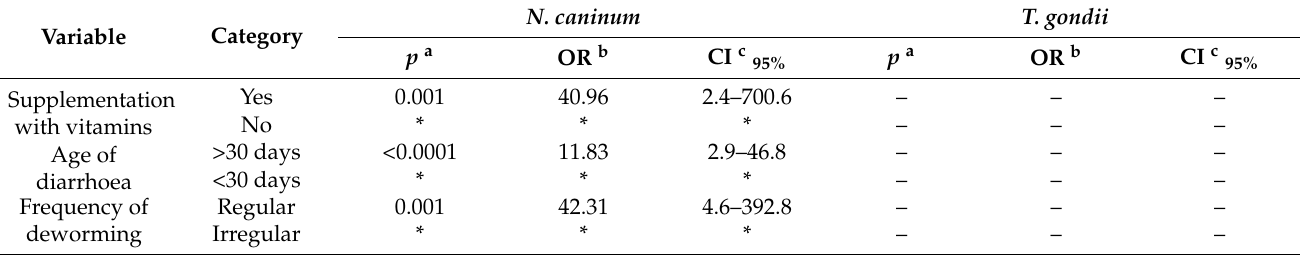
Table 3. Risk factors associated with Neospora caninum and Toxoplasma gondii in goats from Ecuador obtained by multivariable logistic regression